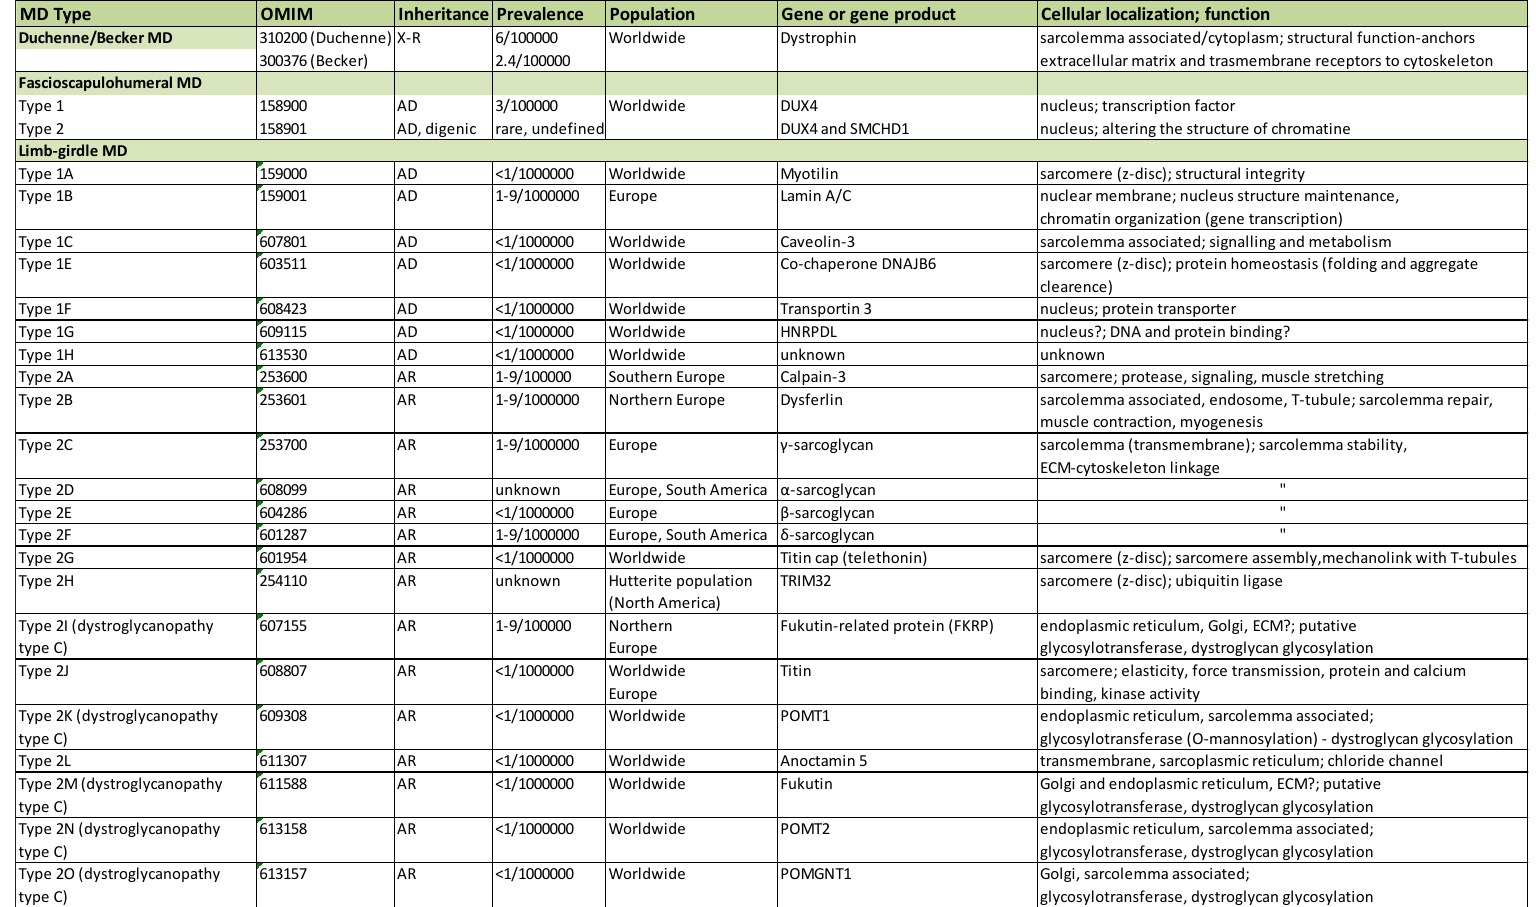
Table 1. MD classification has become increasingly complex. The classification and gene information presented here is based on the Online Mendelian Inheritance in Man (OMIM) database (http://omim.org), the GeneCards database (www.genecards.org), the MalaCards human disease database (www.malacards.org), the Orphanet epidemiological database (www.orpha.net) and the Neuromuscular Disorders Journal list of muscle diseases. AR: autosomal recessive; AD: autosomal dominant; X-R: X-linked; ECM: extracellular matrix; MTJ: myotendinous junction; WWS: Walker-Warburg syndrome; MEB: muscle-eye-brain disease; ?: putative function.